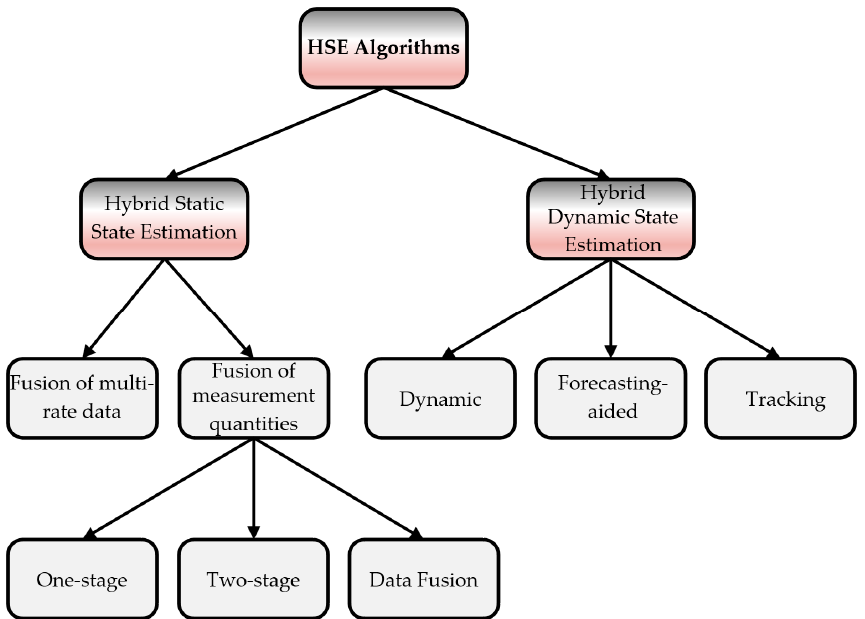
Figure 2. Proposed categorization of HSE methods.